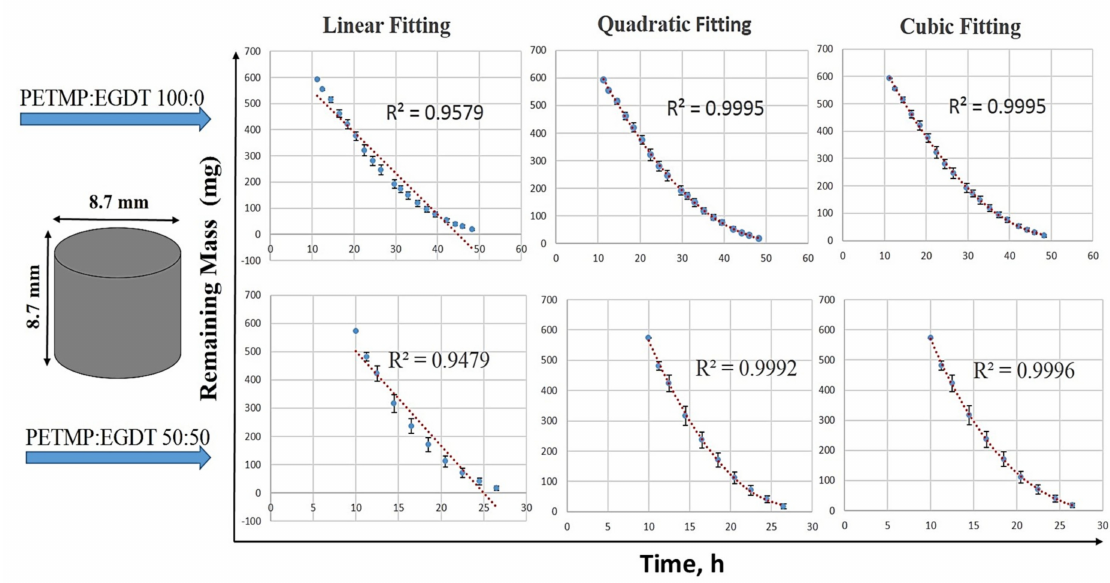
Figure 8. Fitting mass loss data for two cylindrical polymers with initial mole ratios of PNA:PETMP: EGDT = 100:100:0 and 100:50:50 as a function of time. The linear, quadratic, and cubic fits and their R 2 show that the linear equation is not the best-fitted equation and the mass loss is not changing linearly. Table 1. Mass loss data fitting. linear, quadratic, and cubic polynomials were fitted to the mass loss data of four polymers with di ff erent compositions of monomers in two di ff erent shapes.